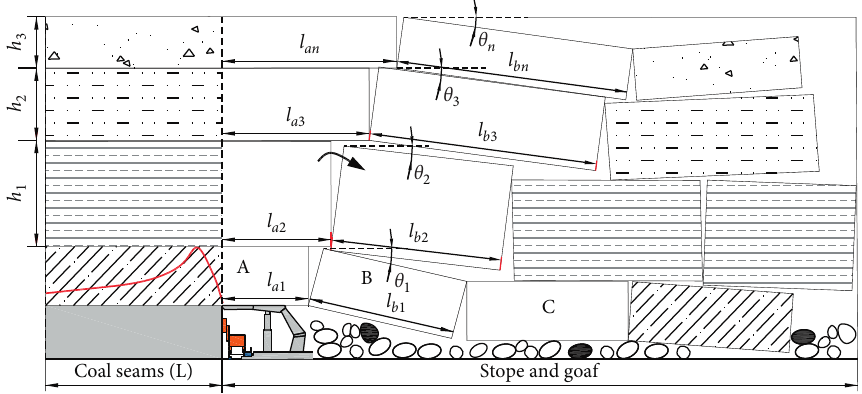
Figure 6: Mechanical model of mining-induced structures at the overlying